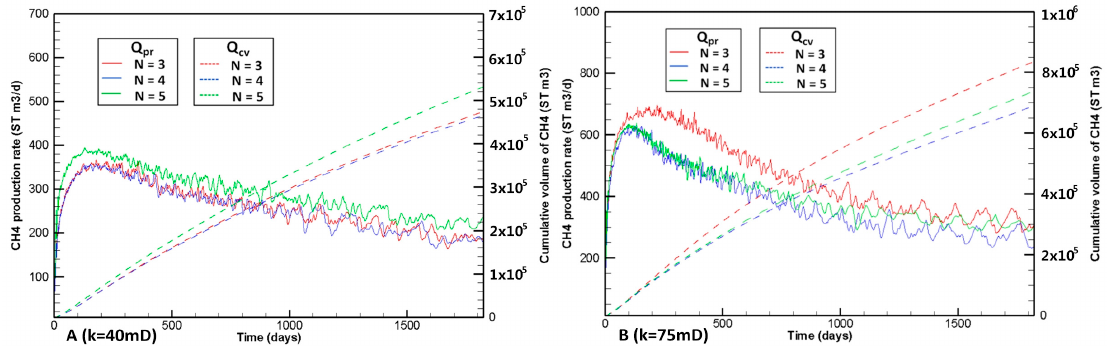
Figure 4. Q pr and Q cv from NGH deposit in the Shenhu area under high-saturation ( S H 0 = 0.5) conditions for different N values ( N = 3, 4, and 5). ( A ) k = 40 mD; ( B ) k = 75 mD.